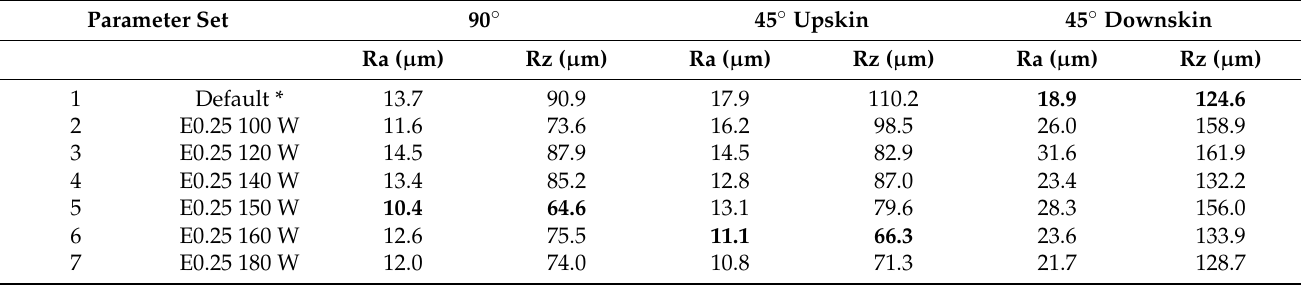
Table 7. Surface roughness for different contour parameters; final parameters are presented in